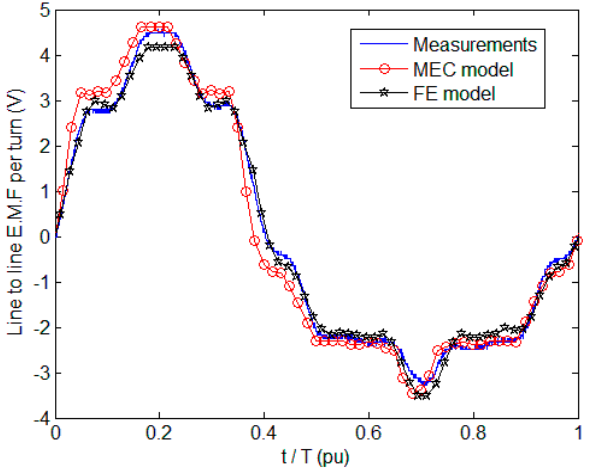
Figure 27. Open-circuit line-to-line EMF per-turn for I exc = 0 A.